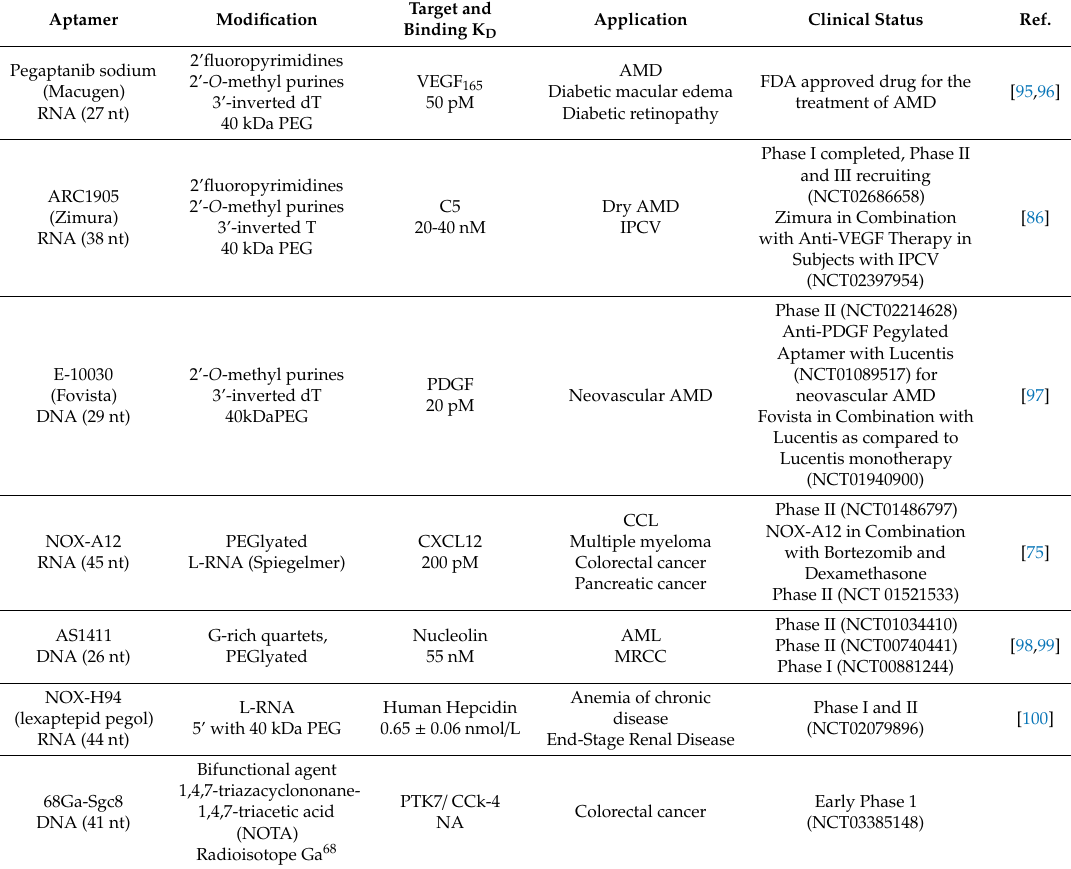
Table 3. Nucleic acid aptamers currently in the